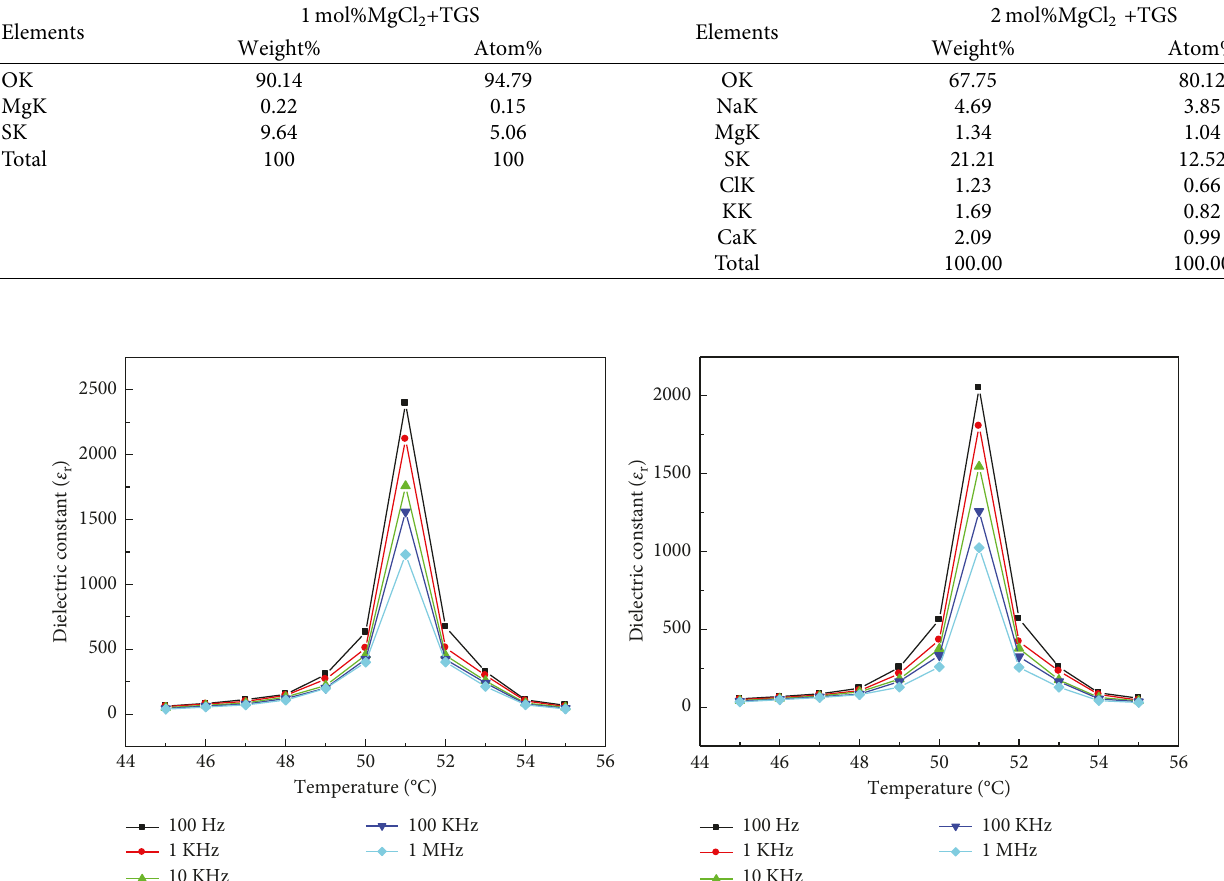
Figure 4: Dielectric constant versus temperature for 1 and 2mol% MgCl